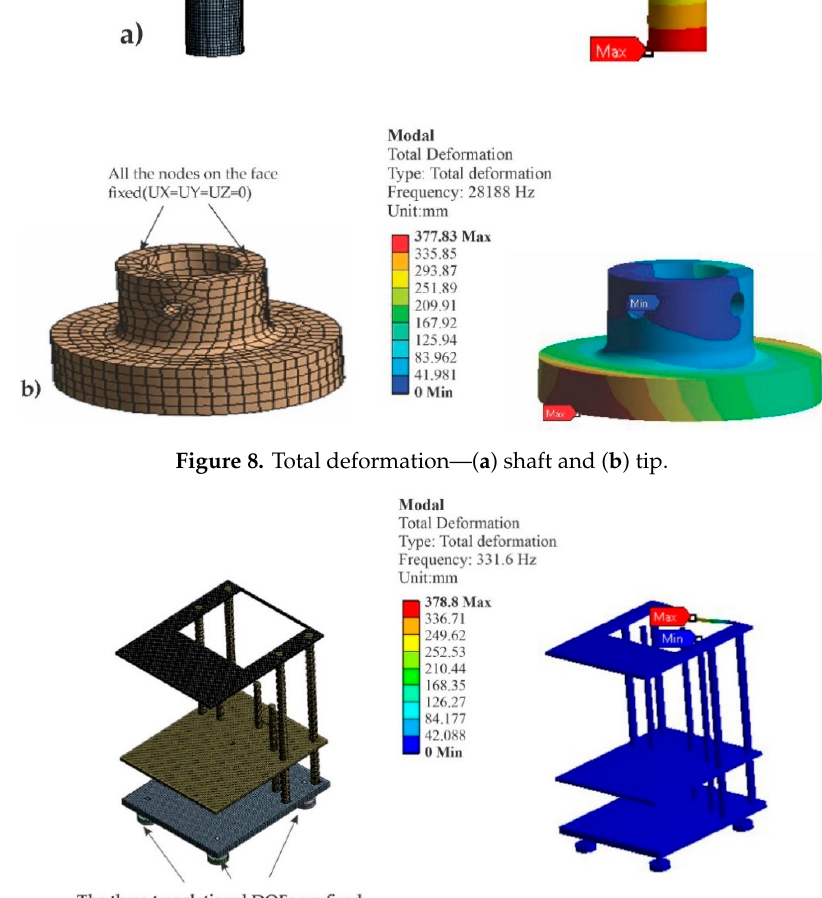
Figure 8. Total deformation—( a ) shaft and ( b ) tip.